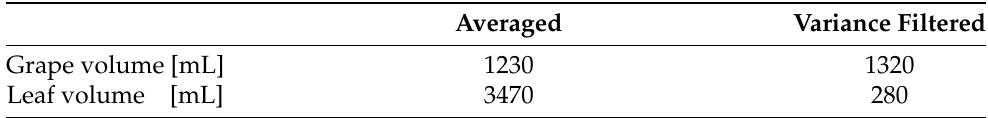
Figure 16. Isosurface visualisation of near-field RX beamformed and TX distortion compensated acoustic scan where echoes from leaves had been mitigated using a fan to agitate the leaves and performing filtering using the average and variance of 20 recordings at each scan point. Table 4. Grape and foliage volume estimates obtained using near-field RX and TX focusing of the array for different types of